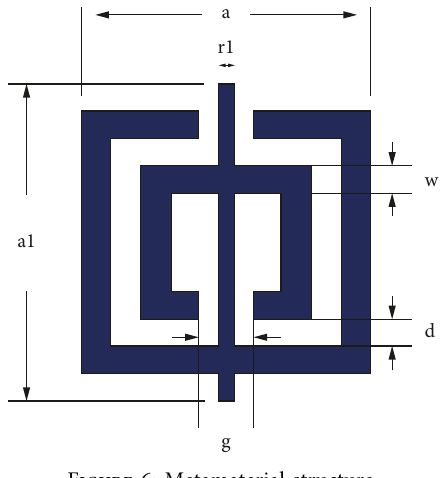
Figure 5: (a) Return loss of the proposed antenna ( f � 2.68GHz and S S 11 � − 18dB). (c) Return loss of the proposed antenna ( f � 7.72GHz and S 11 � − 24dB).